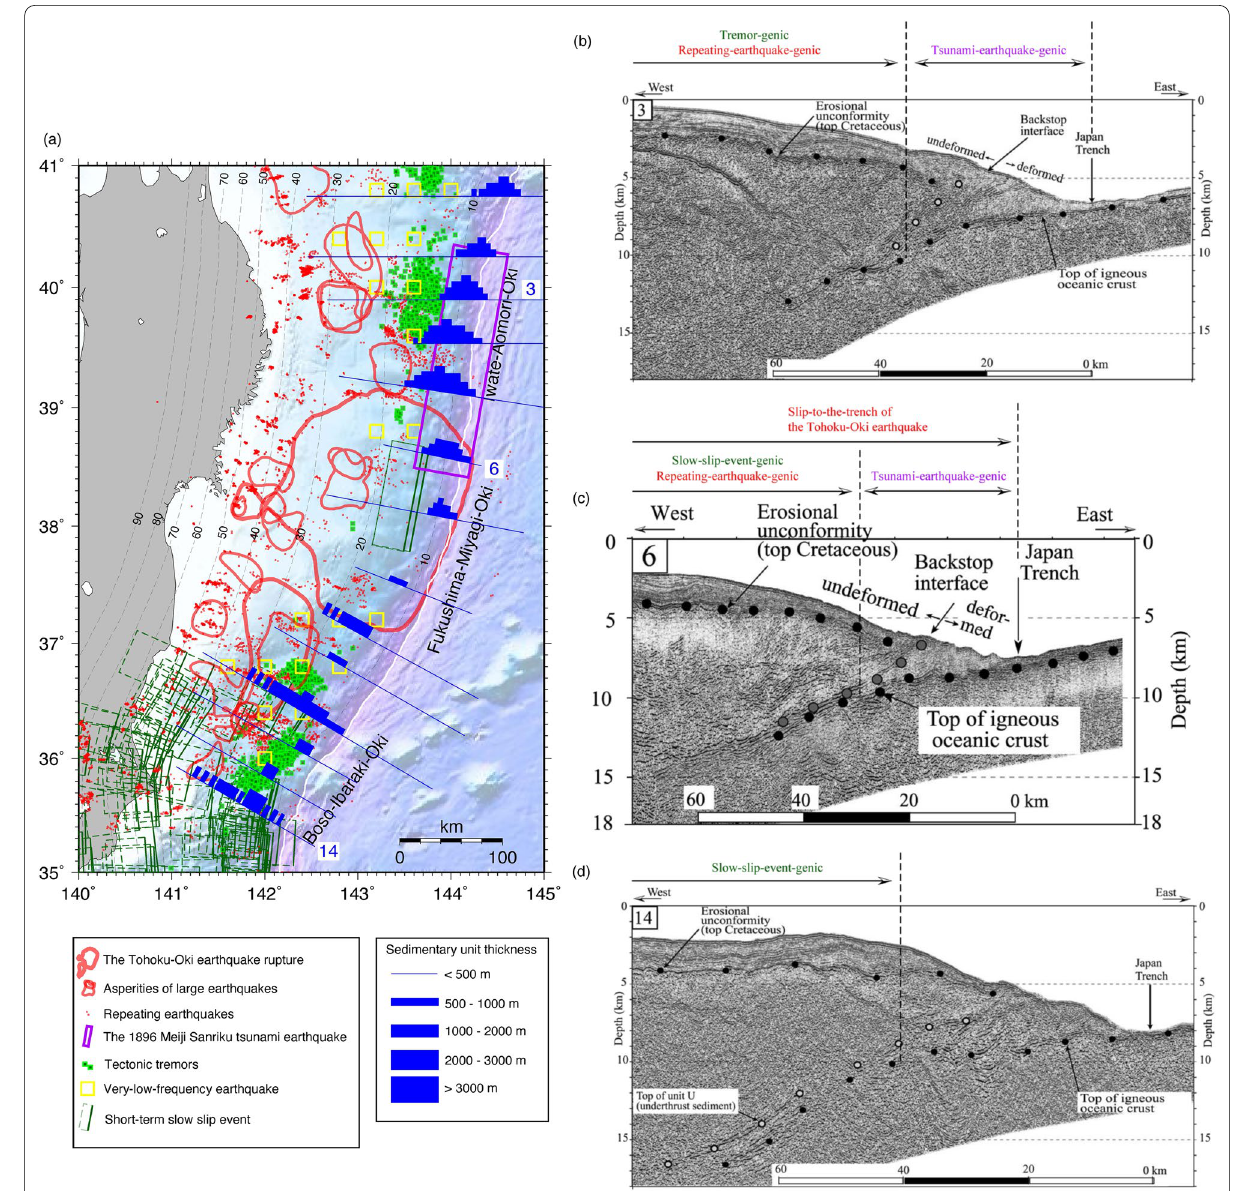
Fig. 11 Comparison between the distribution of interplate sedimentary units and the slow earthquake distribution in the Japan Trench. a Map view of the interplate sedimentary units and slow earthquakes. The distribution of the interplate sedimentary units is from Tsuru et al. (2002). For an explanation of the symbols, refer to the legend in the figure. The slow earthquakes, megathrust earthquakes, and small repeating earthquakes are from Fig. 9. b – d Seismic reflection images of survey line 3, 6, and 14, respectively. The slip behavior of the plate interface is indicated in the images. The seismic reflection images are adapted from Tsuru et al. (2002). Unit U in d indicates the channel-like sedimentary